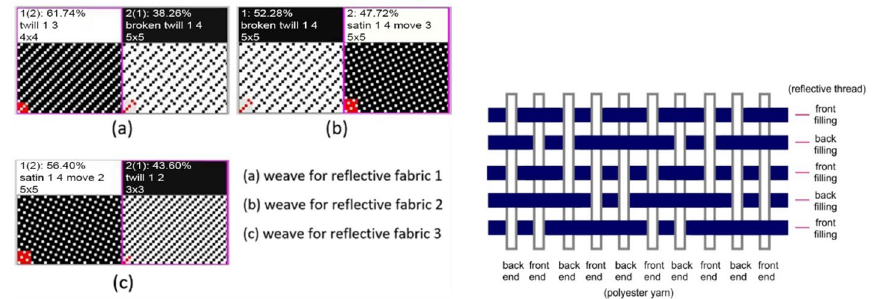
Fig. 6 Weave structure: design on front face and reversed design at back face (Authors Own